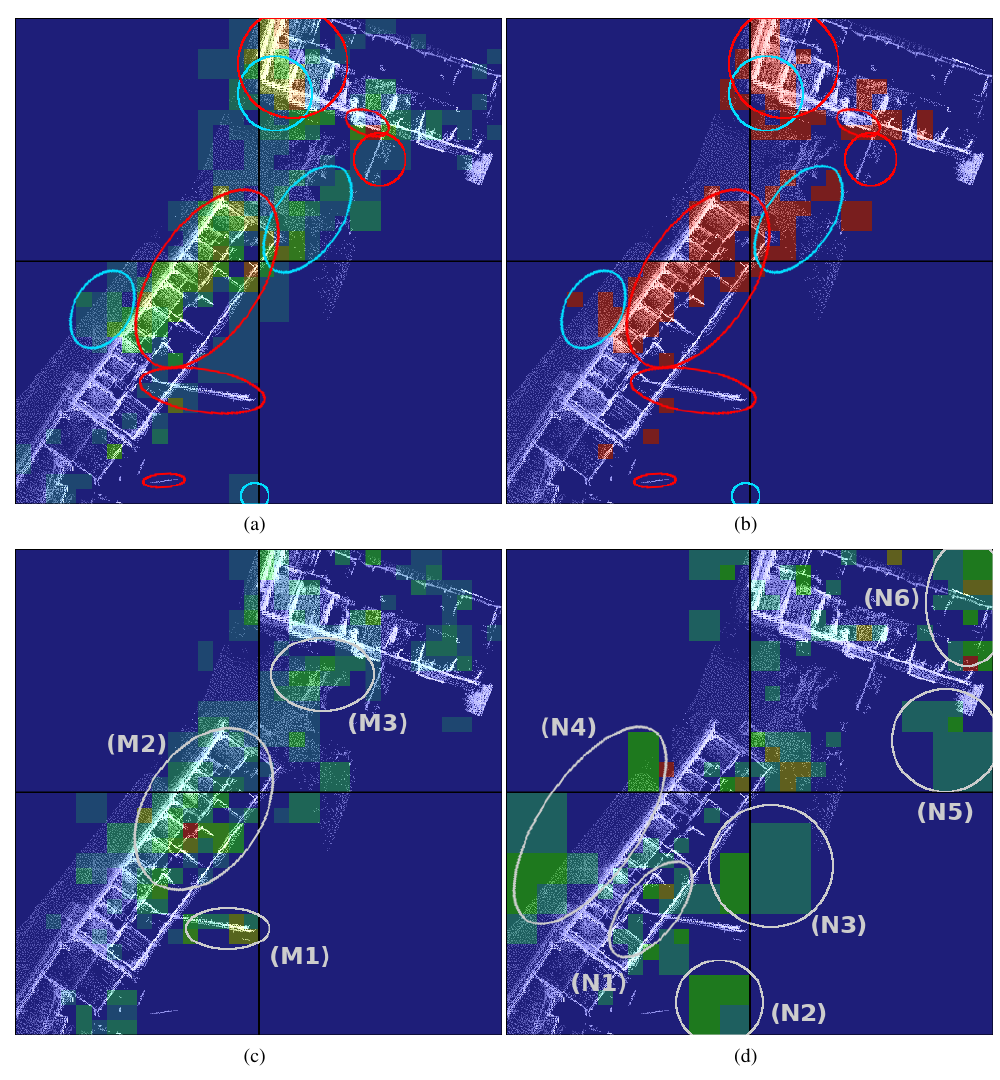
Figure 6. The heatmap in (a) encodes changes regarding both appearance and disappearence, whereas the first ones are annotated with blue circles, the latter one with red ones. A version binarized with a threshold of 0.2 can be seen in (b). The heatmaps in (c) and (d) show missed locations and newly measured locations. All heatmaps are created with a 2m resolution. an octree with 2m resolution is only 51.5%. Also, the maximum spatial resolution is limited by the distance metric used to detect changes. One possible solution that may be explored in future work is it to use measurement rays instead of Gaussians, since these do not require any model